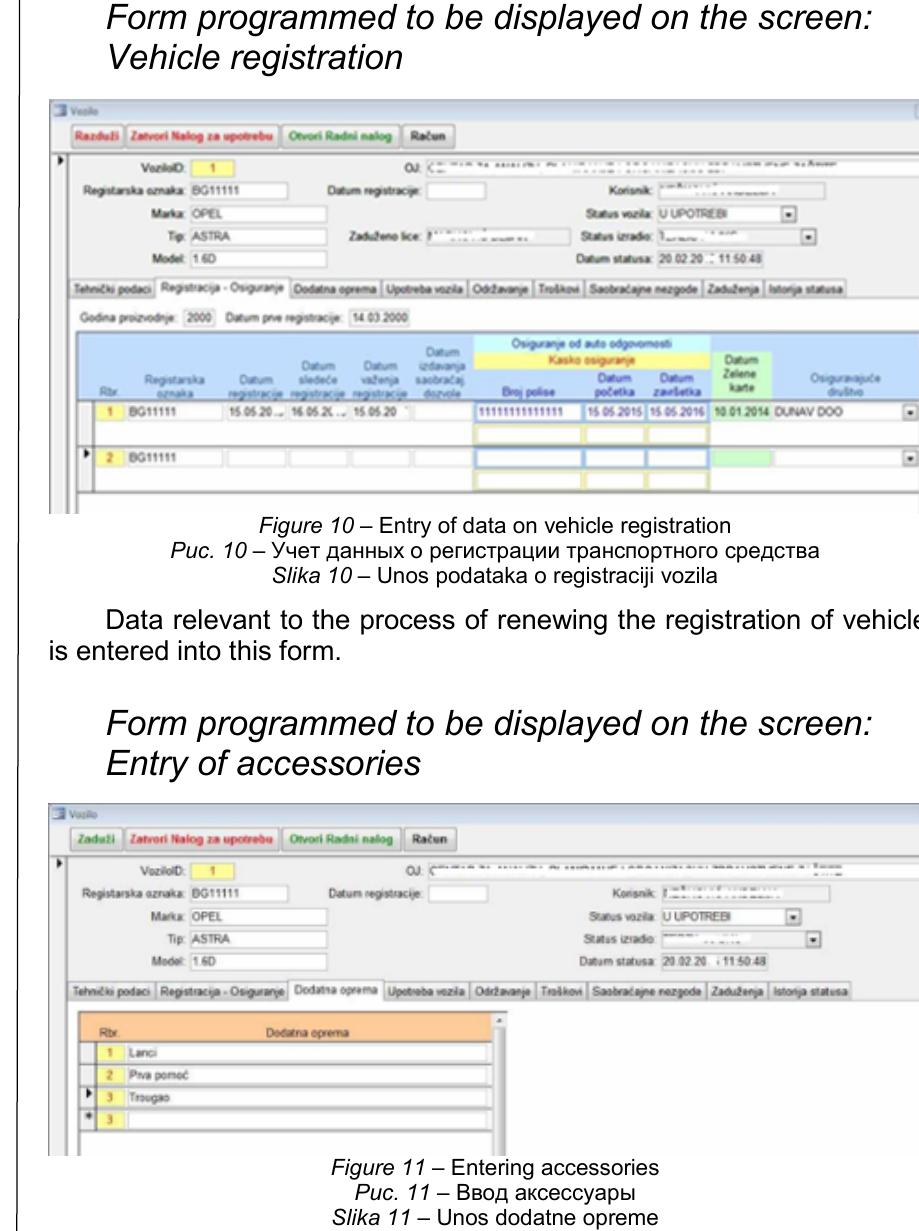
Figure 11 – Entering accessories Рис . 11 – Ввод аксессуары Slika 11 – Unos dodatne